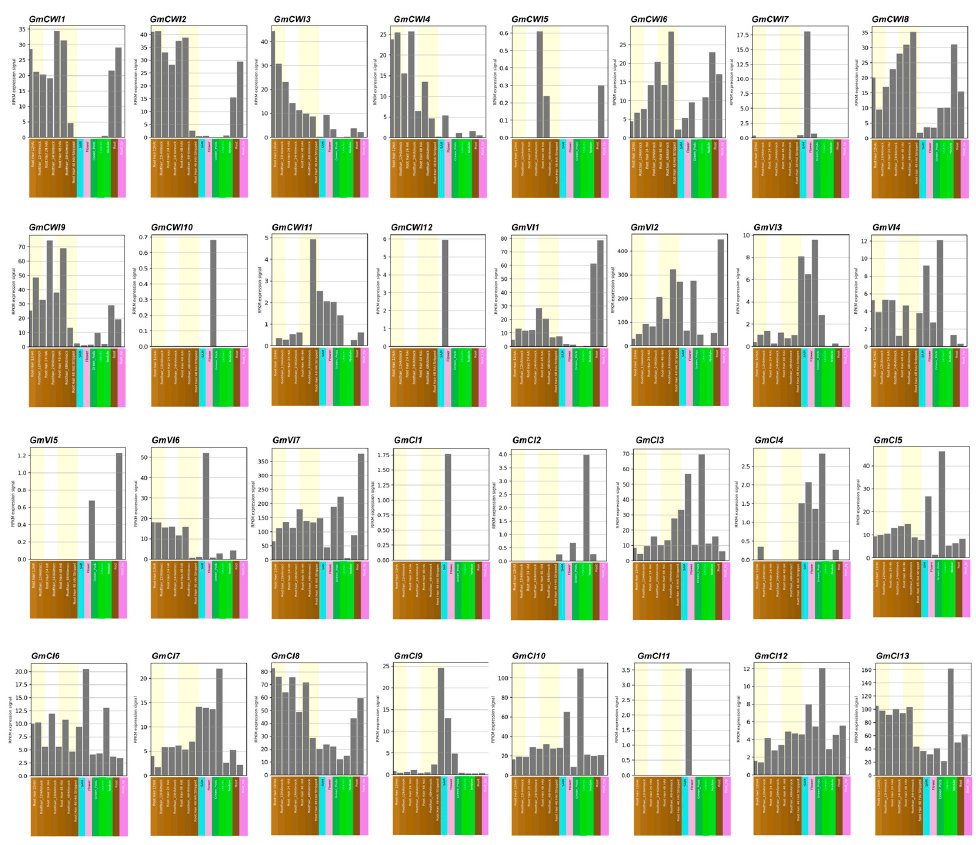
Figure 6. Transcriptomic expression patterns of invertase genes in different tissues of soybean. Tissue-specific expression was derived and analyzed by RNA-seq. Based on the available database of soybean eFP Browser, expression values are given in region per million mapped reads (RPKM) and all materials were sampled in triplicate.